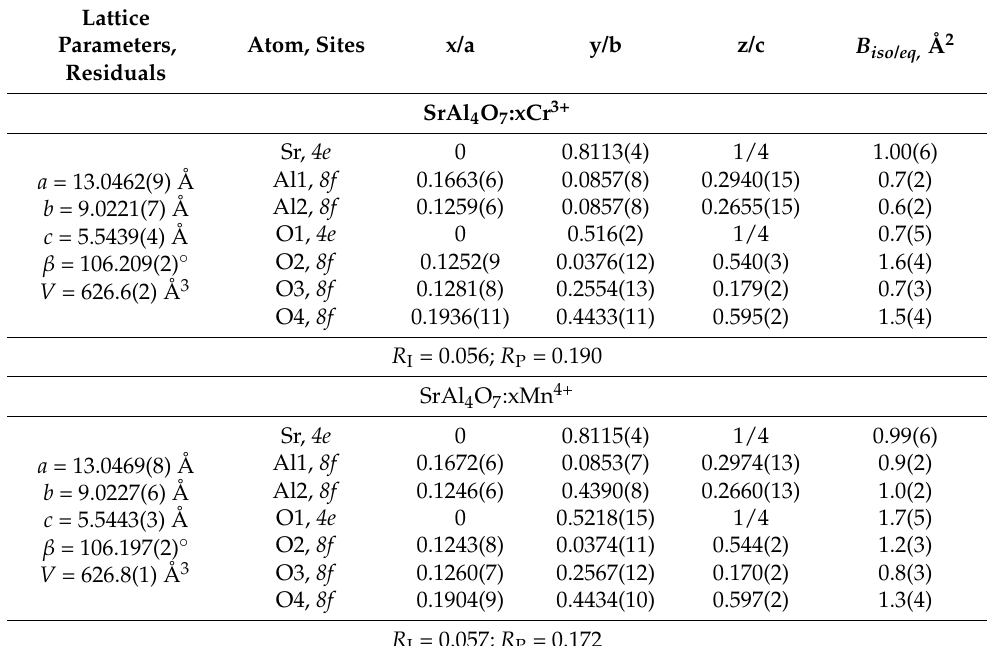
Table 1. Lattice parameters, coordinates, and displacement parameters of atoms in SrAl 4 O 7 :xCr 3+